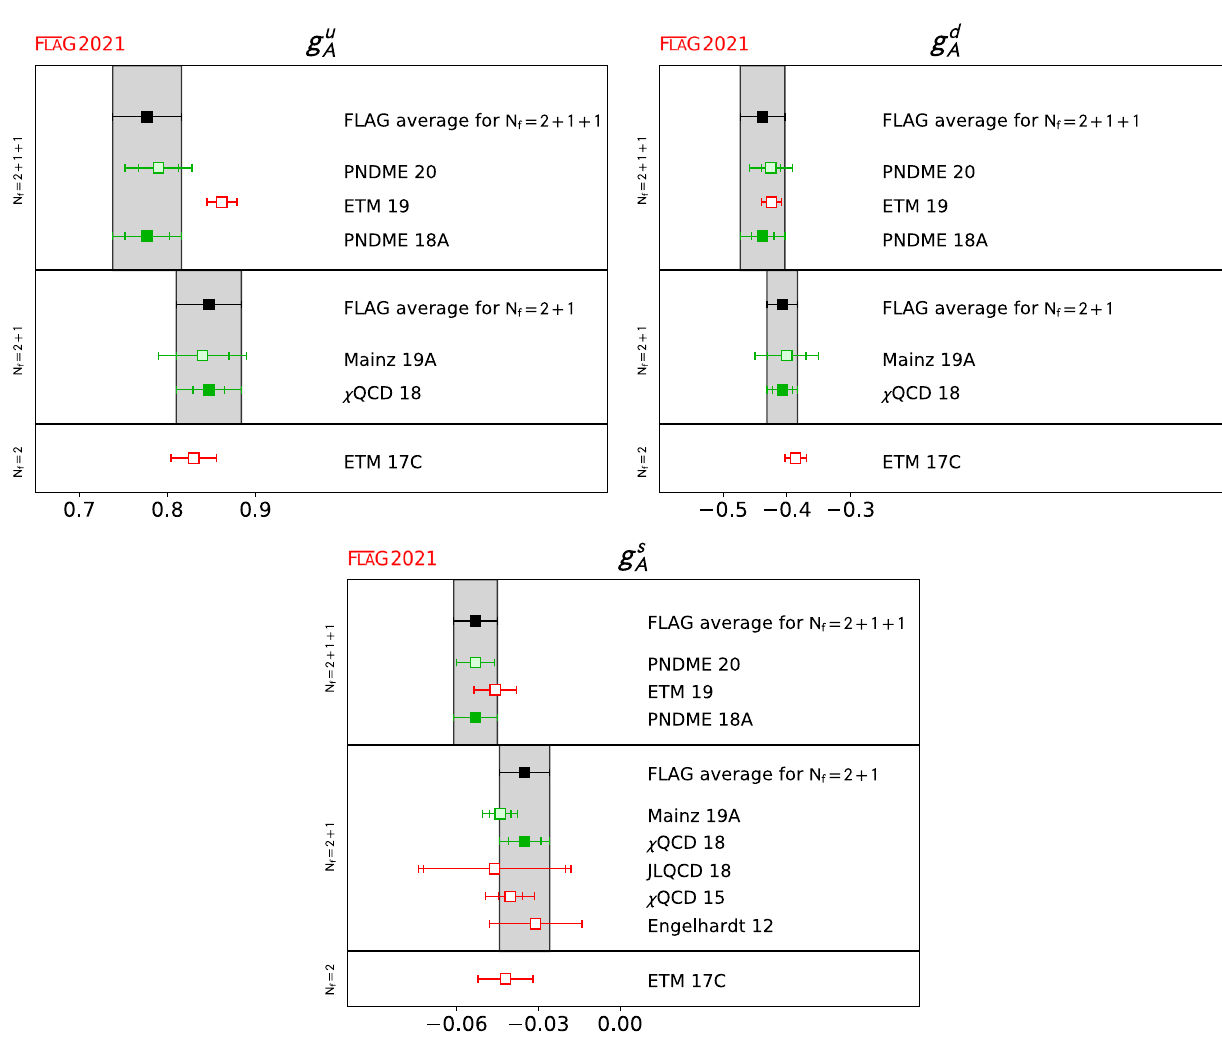
for the N f = 2, 2 + 1, and 2 + 1 + 1 flavour calculations A